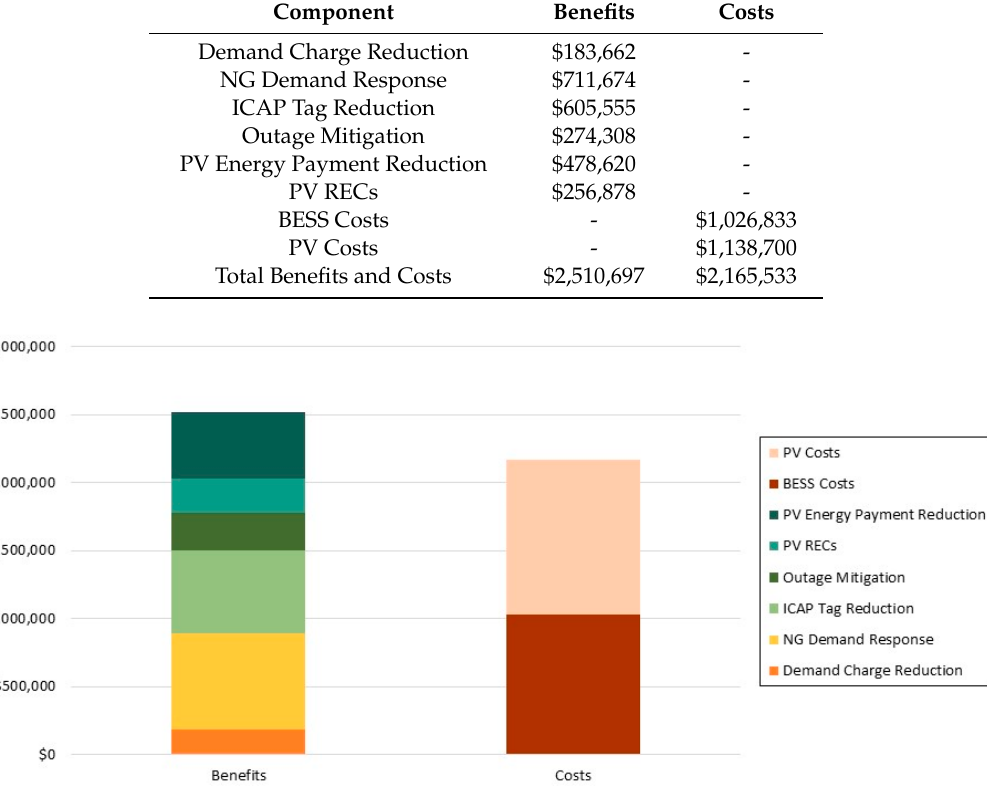
Figure 13. Twenty-year benefits and costs for the Northampton microgrid.